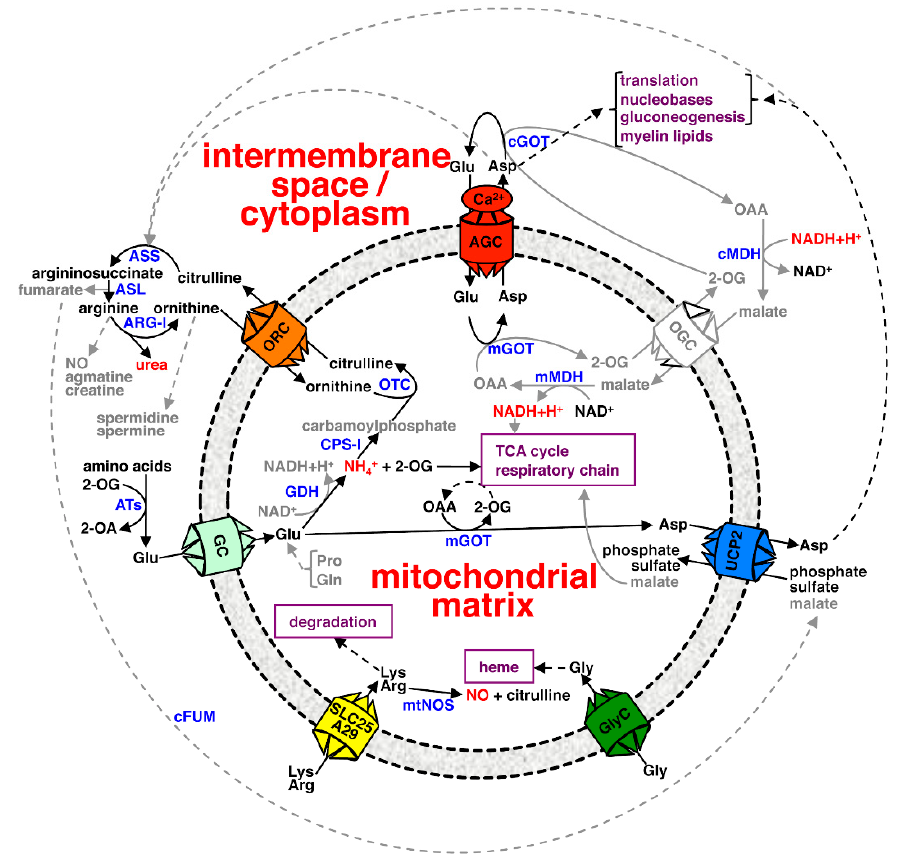
Figure 3. The metabolic roles of MCs transporting amino acids. The schemes do not show all the metabolic pathways in which the individual carriers are involved. The carriers for amino acids are in color, whereas the oxoglutarate carrier is not colored. Substrates are abbreviated in black / gray: 2-OA, 2-oxoacid; 2-OG, 2-oxoglutarate; OAA, oxaloacetate. Enzymes are abbreviated in blue: ARG-I, arginase I; ASL, argininosuccinase; ASS, argininosuccinate synthase; ATs, amino transferases; cGOT and mGOT, cytoplasmic and mitochondrial glutamate oxaloacetate transferase; cFUM, cytoplasmic fumarase; cMDH and mMDH, cytoplasmic and mitochondrial malate dehydrogenase; CPS-I, carbamoyl phosphate synthetase I; GDH, glutamate dehydrogenase; mtNOS, mitochondrial nitric oxide synthetase; OTC, ornithine transcarbamoylase.